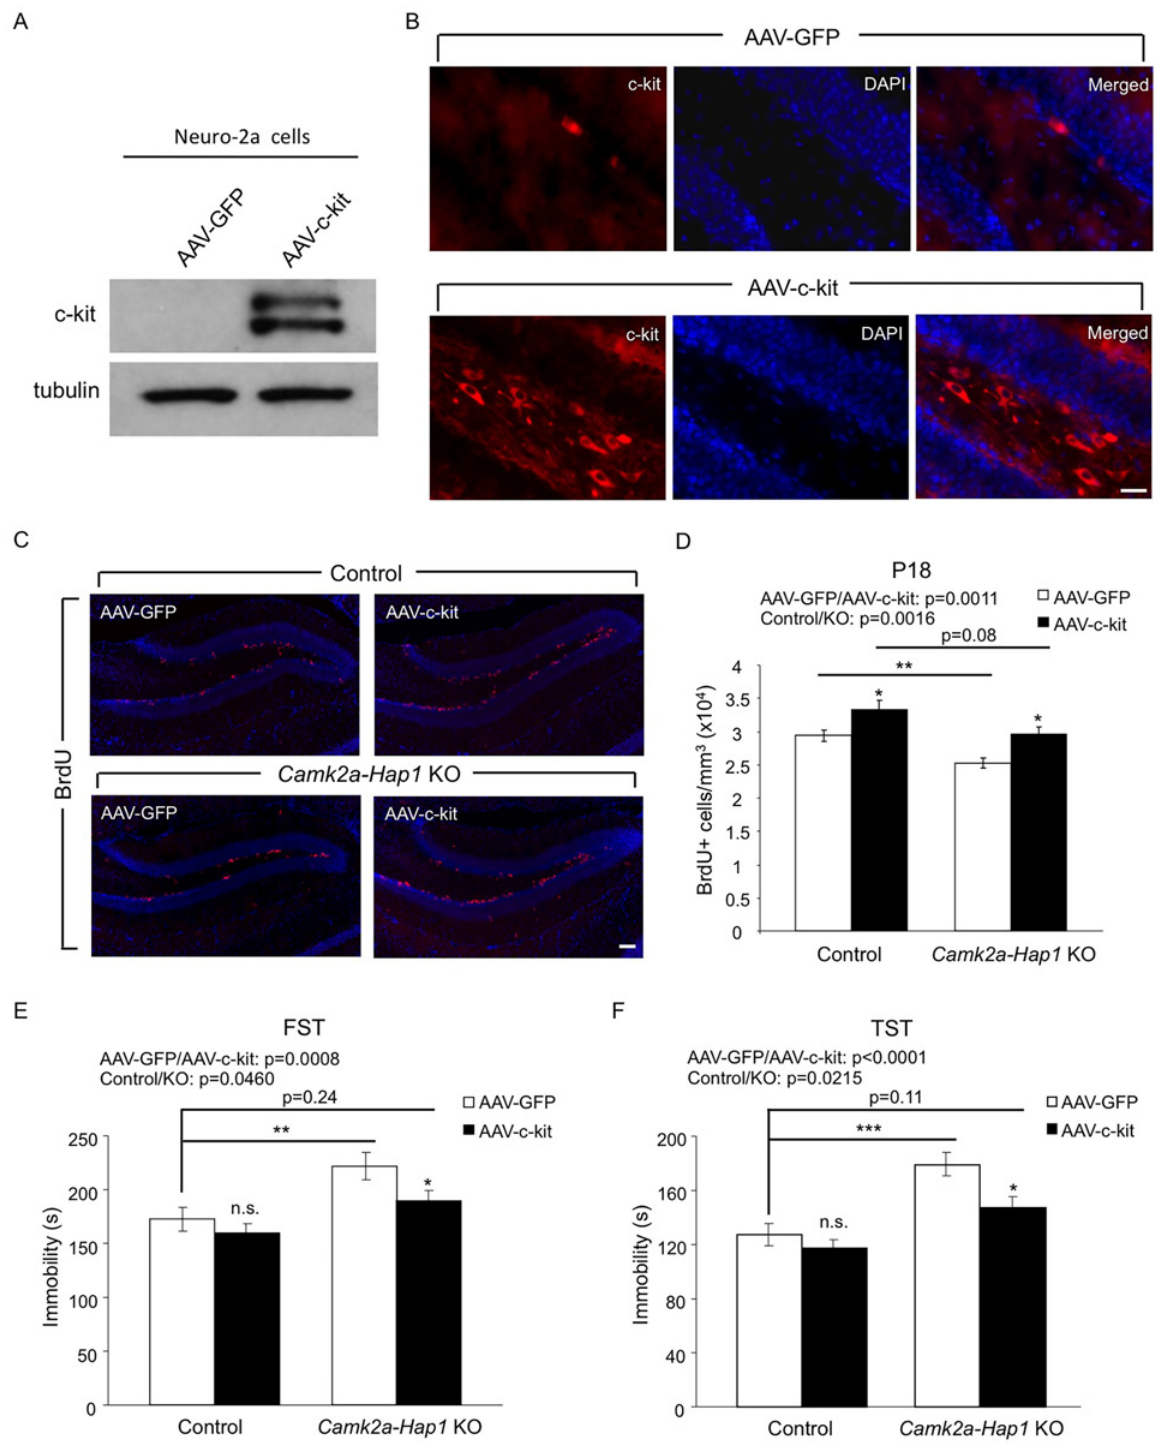
Fig 7. Overexpression of c-kit rescues postnatal neurogenesis defect and adult depressive-like phenotype in camk2a-Hap1 KO mice. ( A ) Neuro-2A cells were infected with AAV-c-kit or control virus for 72 hours, and the expression of c-kit was analyzed by western blot. The top band may be the precursor of c-kit, which is not present in the brain lysate. ( B ) AAV-c-kit was stereotaxically injected into P3 mouse hippocampus. Two weeks later, the expression of c- kit in the hippocampus was examined by immunostaining, which showed robust expression of c-kit in the hilus and subgranular zone of the DG. AAV-GFP injection served as a control. ( C-D ) C amk2a-Hap1 KO and control mice at P3 were injected with AAV-c-kit or control GFP virus into the hippocampus.